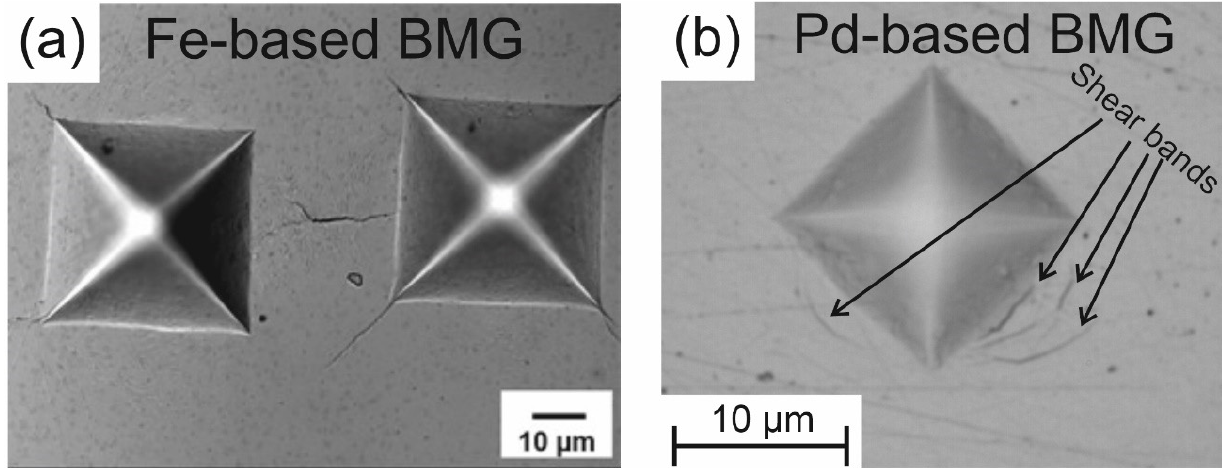
Figure 43. ( a ) Cracking at the corners of two hardness indents on a Fe-based BMG [42]; ( b ) shear band formation due to the deformation induced by a hardness indent on a Pd-based BMG [73].